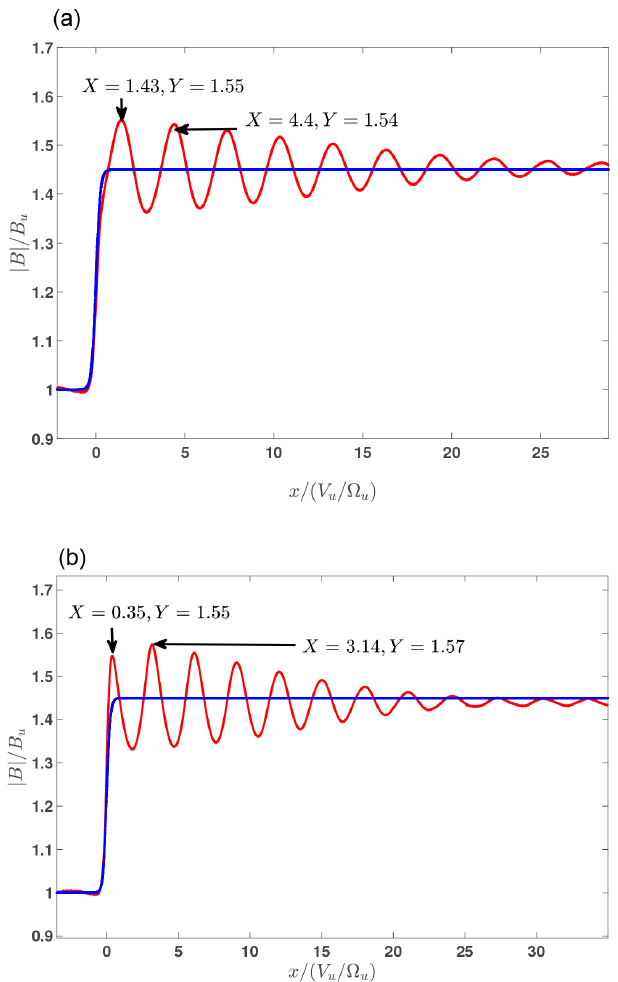
Figure 1. Comparison of the derived magnetic profiles (red) for s NIF = 0 . 4 (a) and s NIF = 0 . 65 (b) . In both cases R = 1 . 45, M = 1 . 4, and D = 1 /M . The model magnetic field is shown by the blue line.